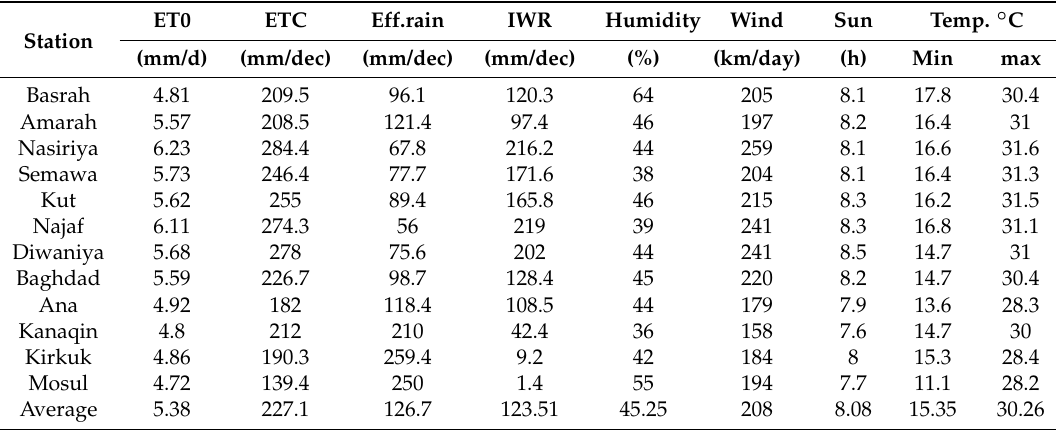
Table 2. Data for evapotranspiration (ETc), effective rainfall (Eff.rain), irrigation water requirements (IWR) and related variables in the study area for the period from (1971 to 2000) obtained by the CROPWAT and CLIMWAT